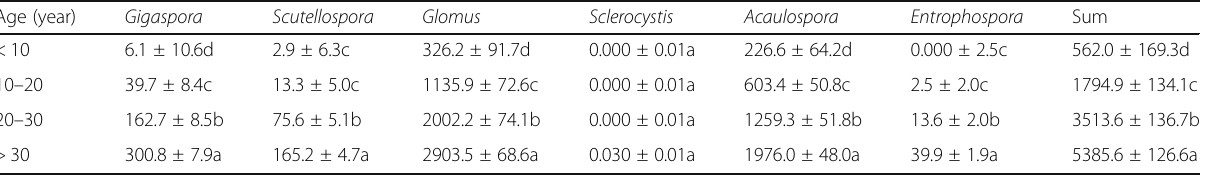
Table 4 AMF spore density and spore genera in four age classes of exclosures (100 g − 1 of dry